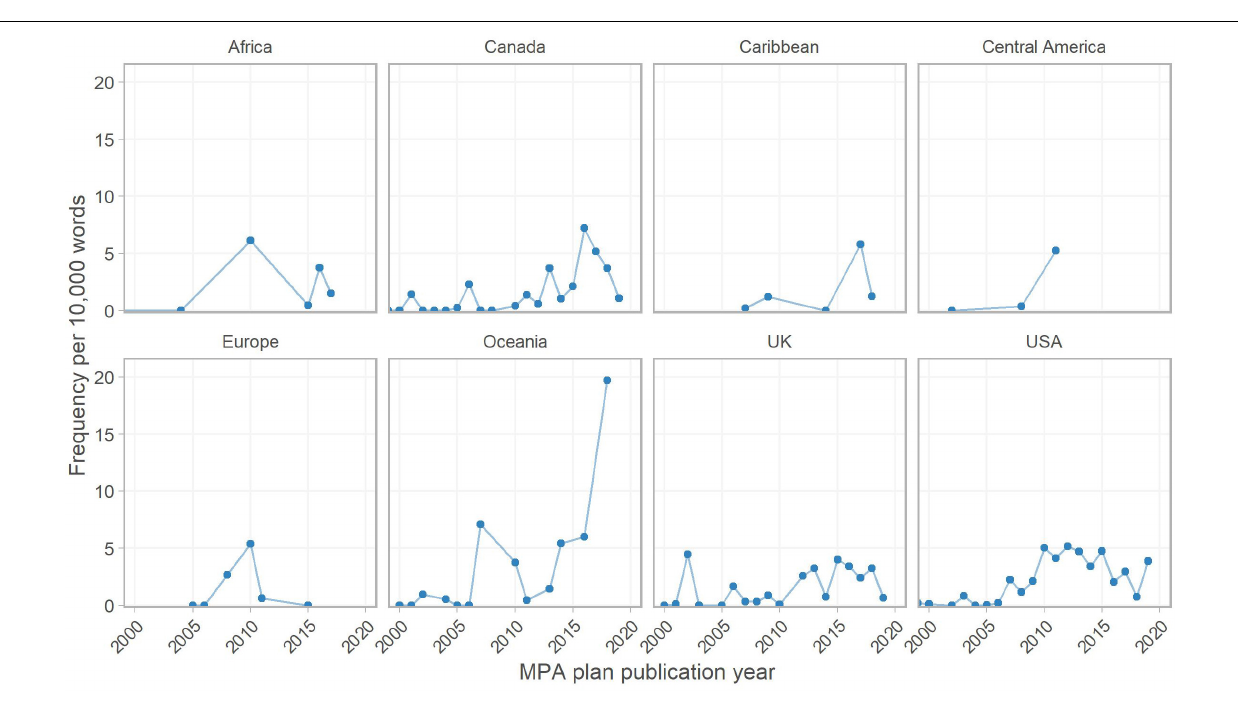
FIGURE 2 | The frequency per 10,000 words of the term “climate change” in all MPA management plans published between 2000 and